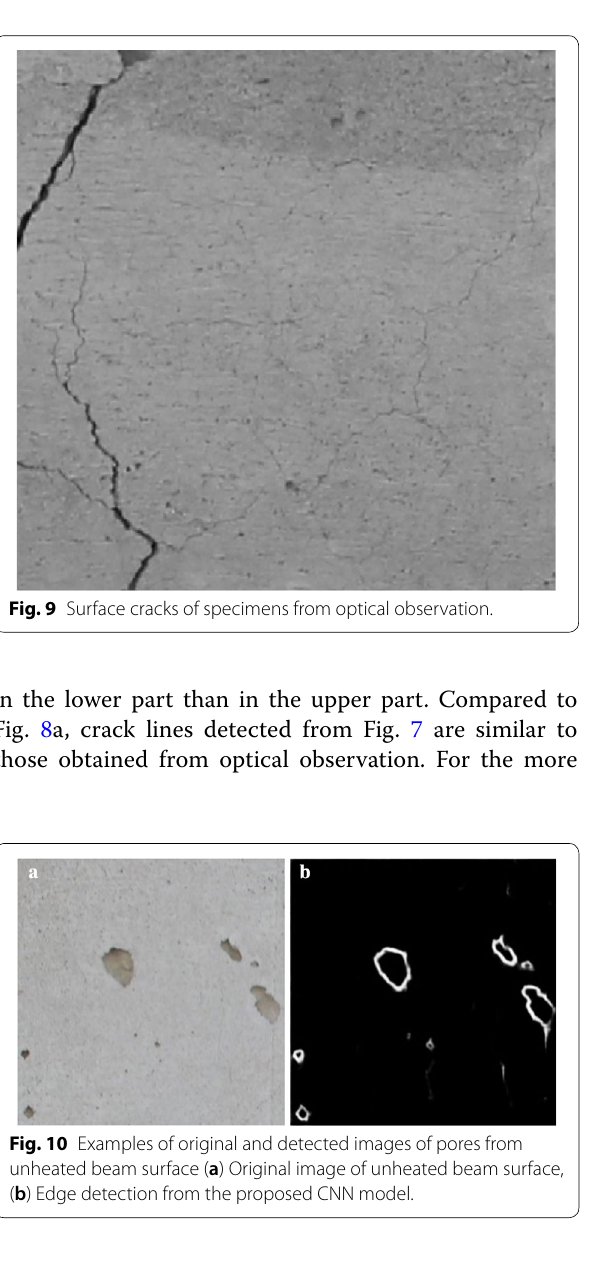
Fig. 10 Examples of original and detected images of pores from unheated beam surface ( a ) Original image of unheated beam surface, ( b ) Edge detection from the proposed CNN model.